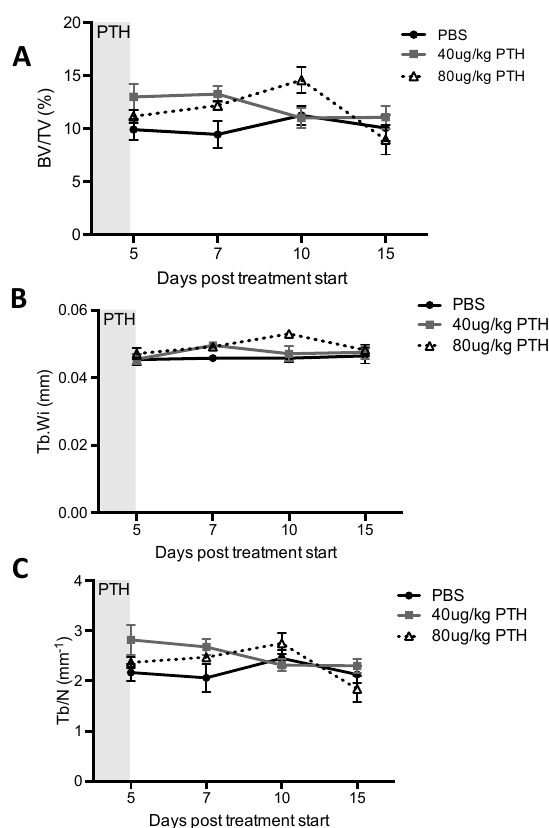
Figure 2. Effects of intermittent PTH on bone remodeling in 12-week old BALB/c nude mice. μCT analysis was performed on the proximal tibia of mice treated with 40 μg/kg or 80 μg/kg PTH or PBS for 5 days and mice were culled on day 5, 7, 10 and 15. Graphs show measurements of ( A ) trabecular bone volume per tissue volume (expressed as % BV/TV), ( B ) trabecular width (Tb.Wi, mm) and ( C ) trabecular number (Tb/N per mm). Data is presented as mean ± SEM and statistical analysis was performed using two-way ANOVA and multiple comparison post-test. A minimum of n = 5 animals per time point and treatment group were analyzed.